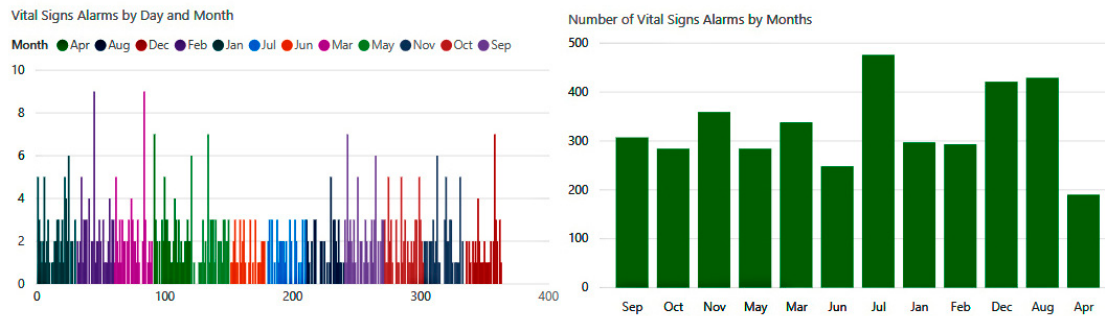
Figure 21. Number of alarms when the vital signs are abnormal.